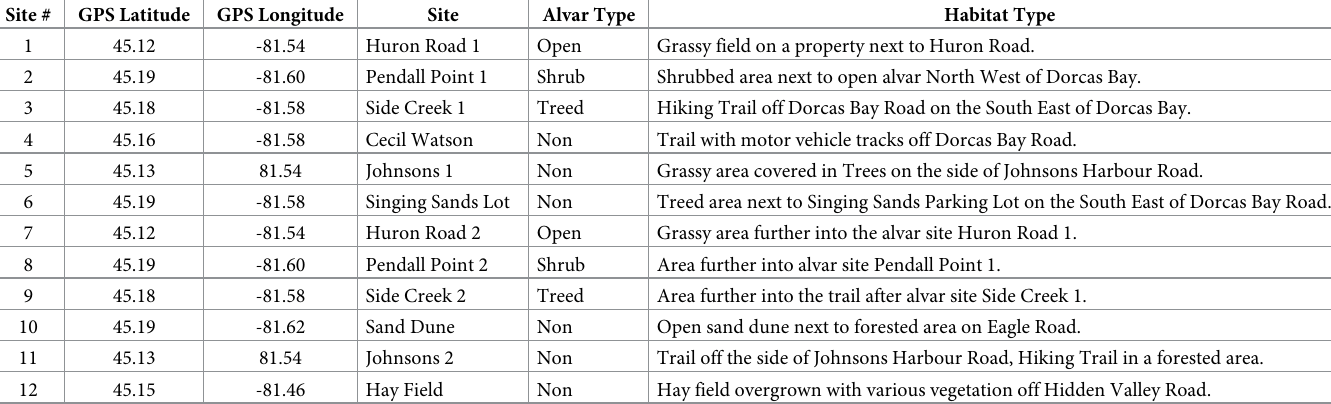
Table 1. Description of sites used to reintroduce micropropagated Hill’s thistle plants in June 2, 2017 (site 1 to 6) and July 18, 2017 (site 7 to 12) at Bruce Peninsula National Park in Tobermory, Ontario. Twenty-five plants were randomly assigned to plots within an area of 20 m 2 on each